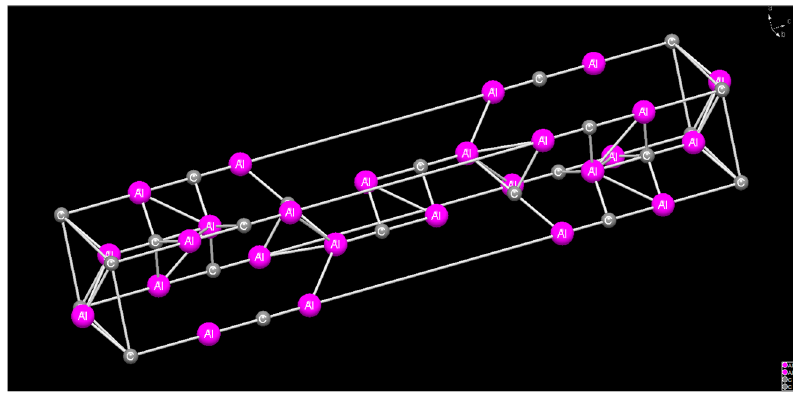
Figure 10. Al 4 C 3 crystal structure.